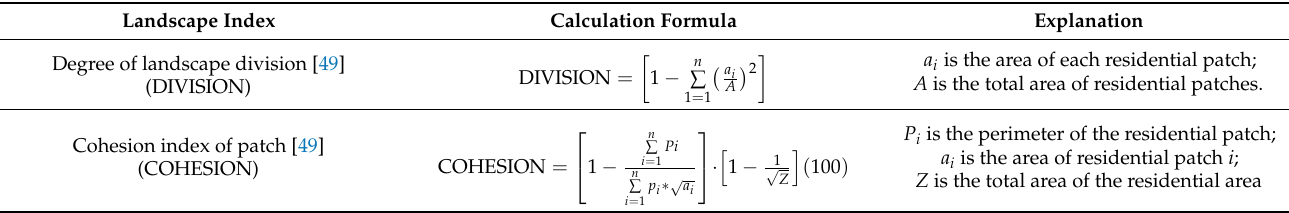
Table 1. The selected landscape